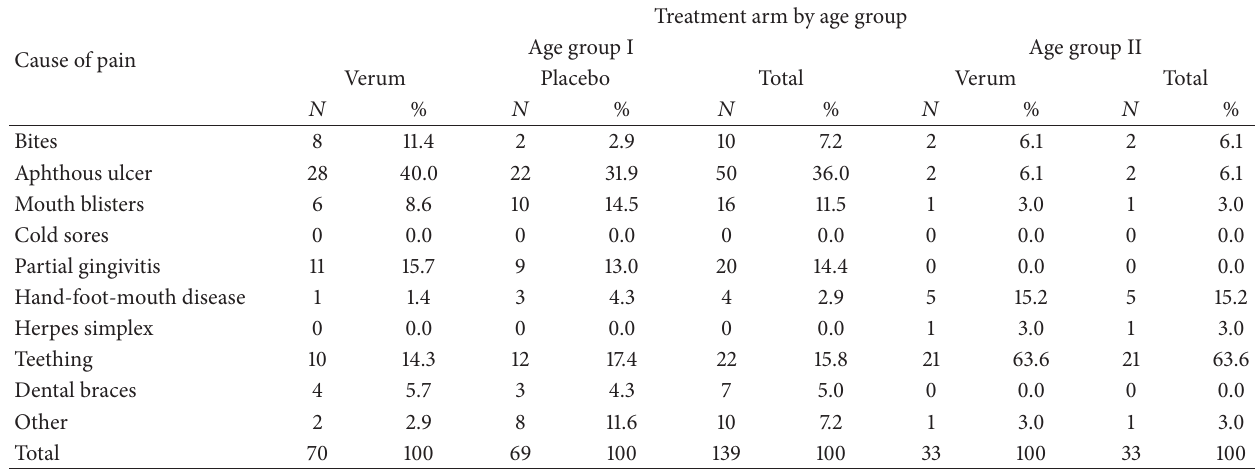
Table 1: Cause of painful sites by age group and treatment arm.